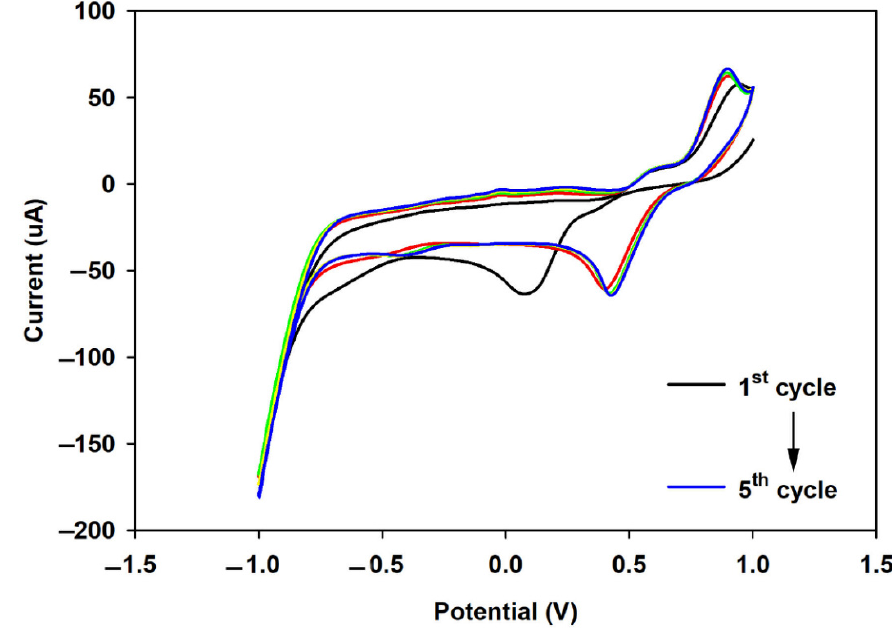
Figure A5. The voltammograms of five successive CV cycles used to deposit AuNPs.